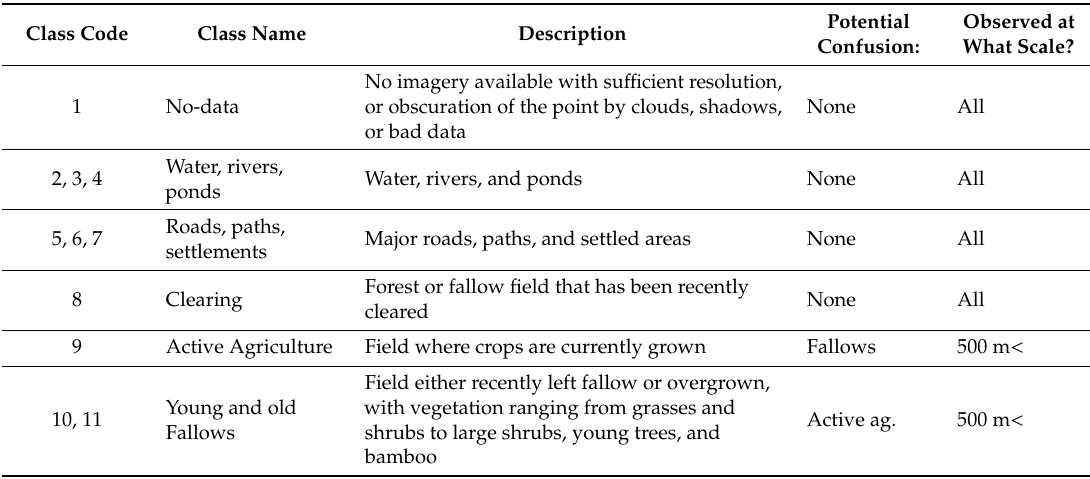
Table 1. The legend of land cover and land use classes that can be attributed to each sample point and their buffers in photo-interpretation.